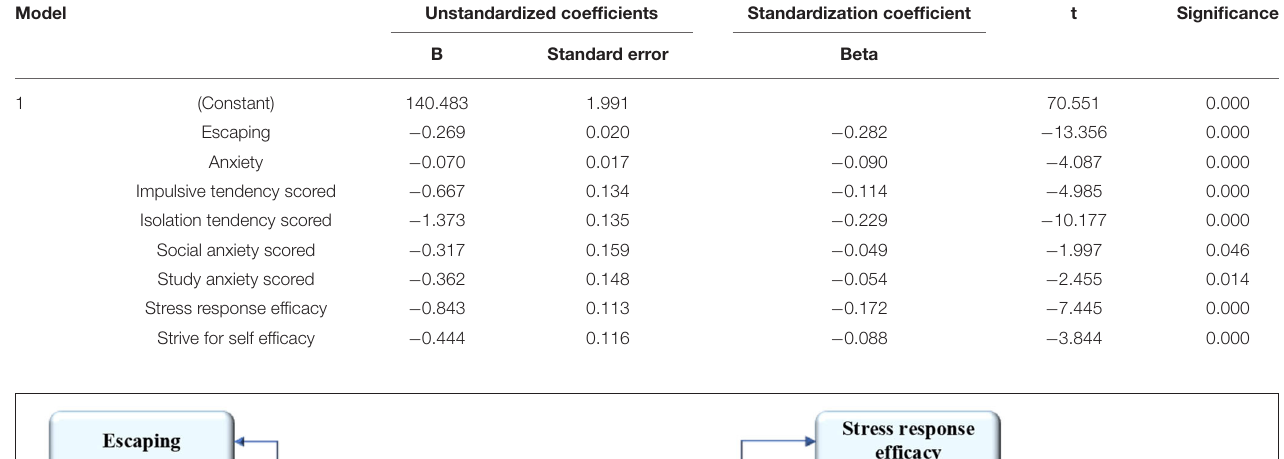
TABLE 3 | A linear regression model for resilience of children in plight. Model